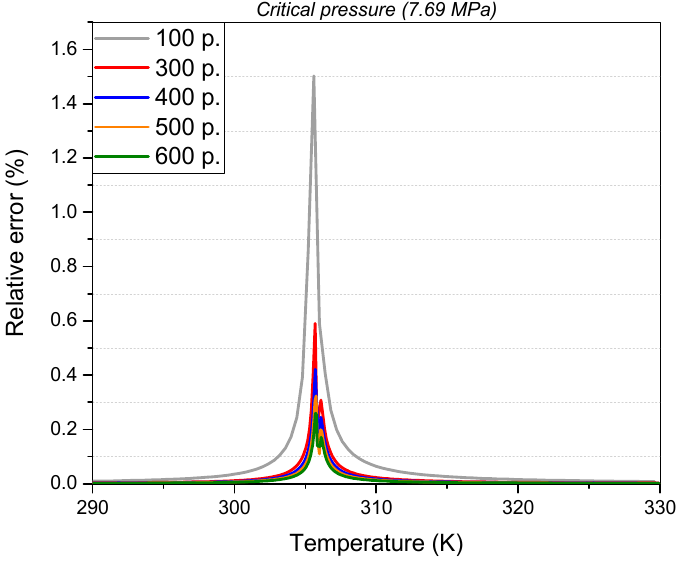
Figure 6. Relative error of specific heat (cp) in the region around the critical point for pressure of 7.69 MPa as the points of the look-up table increase.